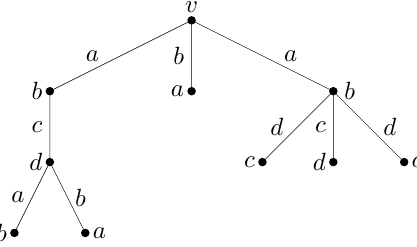
Figure 1: An ( a, b, c, d ) -coloring of a rooted tree with root v